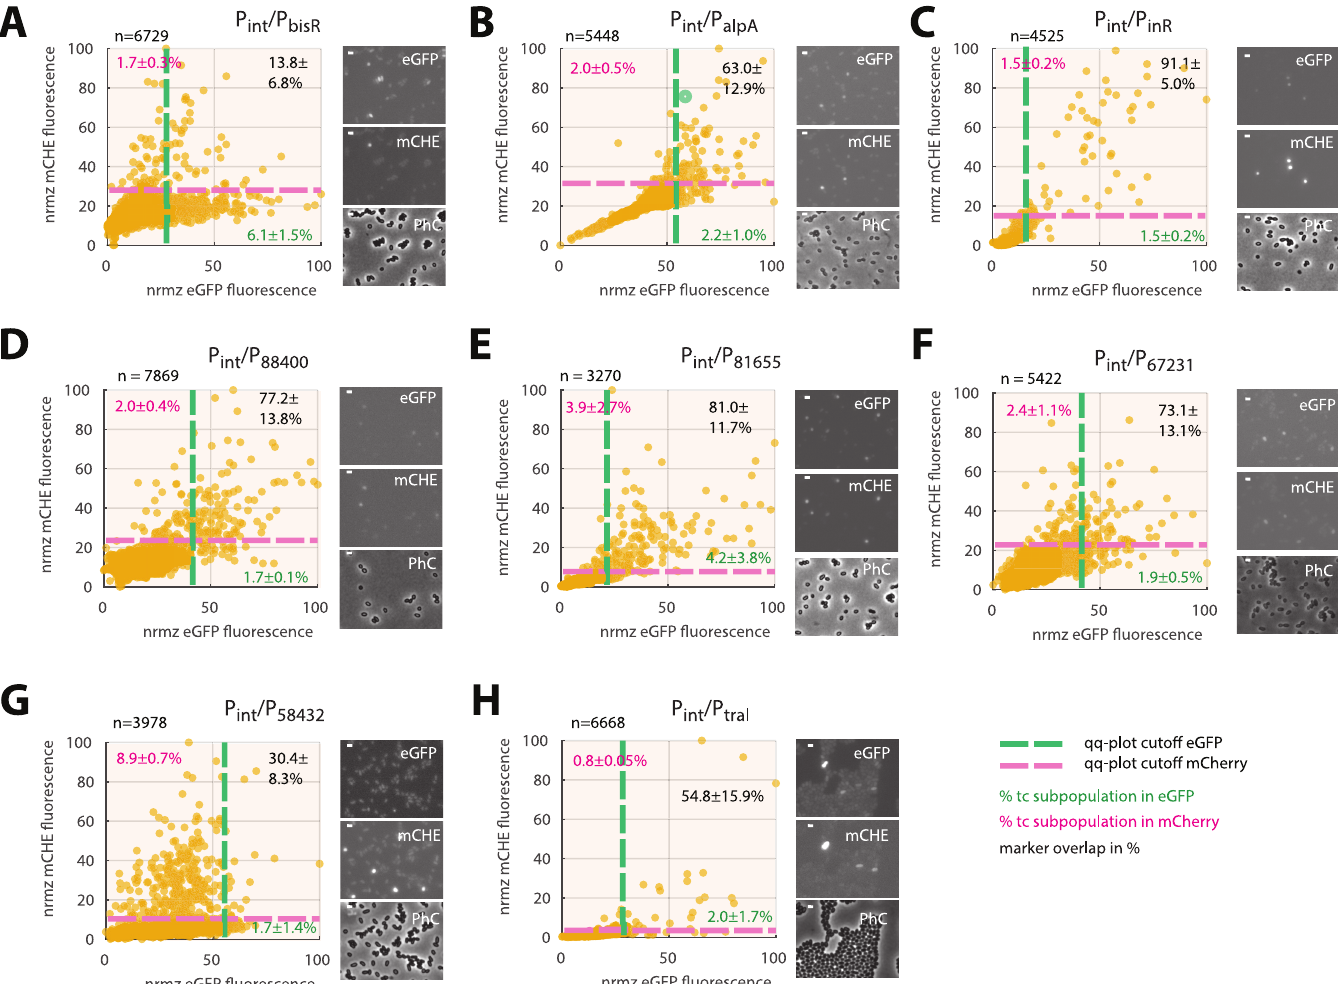
Fig 4. Colocalization of expression of paired bimodal promoters from the ICE clc transfer competence regulon. Dots show stationary phase normalized fluorescence values (72-h-cultures on 3CBA, background subtracted and scaled to the maximum value within a data set) of individual P . knackmussii B13 ( A - G ) or P . putida ICE clc ( H ) cells carrying the indicated (single copy integrated) double reporter construct. Insertion position of P int - mcherry the same in all strains, except for H ( P . putida ). Plots combined from three biological replicates ( n is total amount of analyzed cells) with micrographs on the right showing example images in GFP, mCherry and phase- contrast (auto-contrasted for display). Dashed magenta and green lines delineate the main from subpopulations (defined from quantile-quantile plots as in Fig 3B, percentages showing the mean subpopulation size ± one SD from n = 3 biological replicates). Percentages on the upper right indicate the mean proportion ± one sd of cells in the overlap (brown) of green and magenta channels. Bars within micrographs indicate 1 μ m.